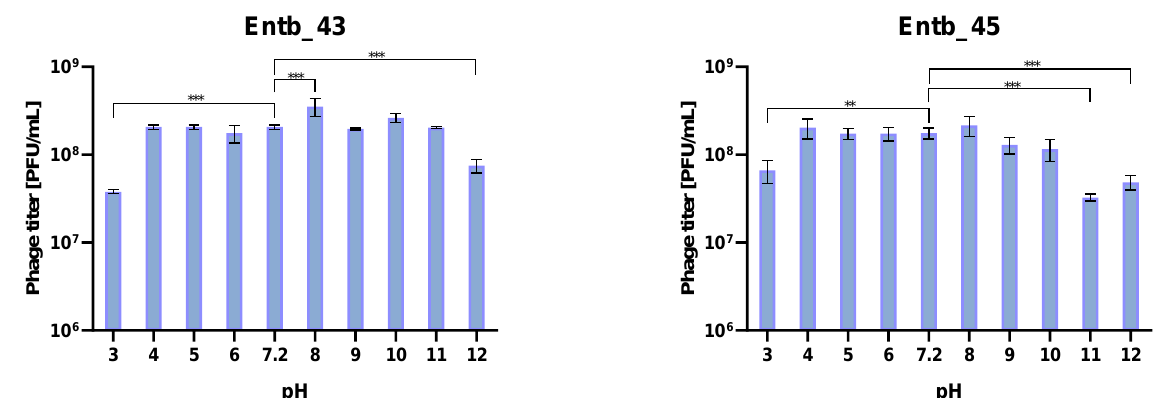
Figure 9. Phage titers after one-hour incubation in different pH solutions. Samples incubated in a medium with pH = 7.2 were treated as controls. Error bars represent the standard deviation (±SD) of the mean phage titers. ** p < 0.01; *** p < 0.001.